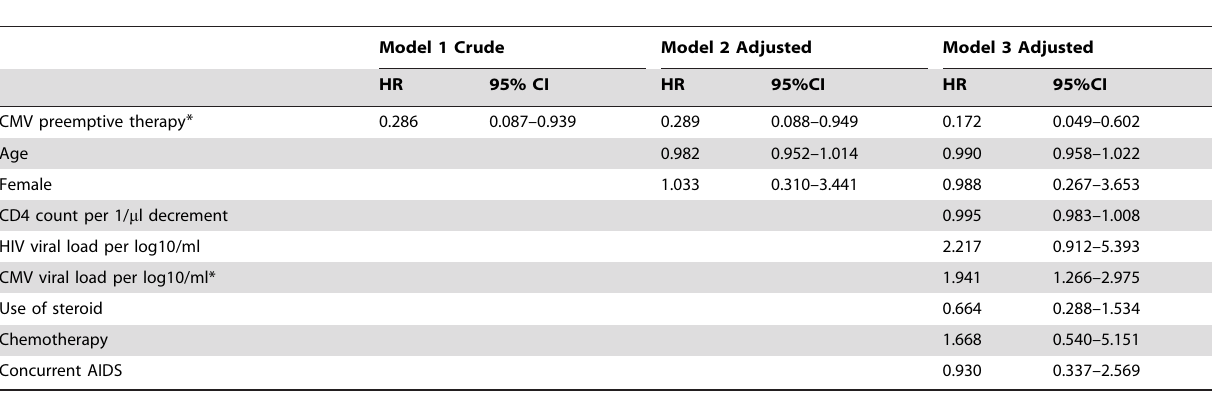
Table 3. Results of multivariate analysis to estimate the preventive effect of CMV preemptive therapy against CMV end-organ disease.